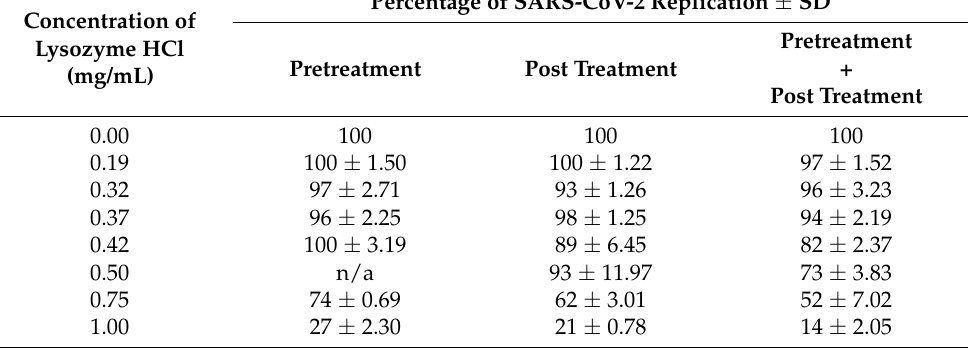
Table 1. Antiviral activity of lysozyme HCl against SARS-CoV-2, expressed as percentage of viral replication ±